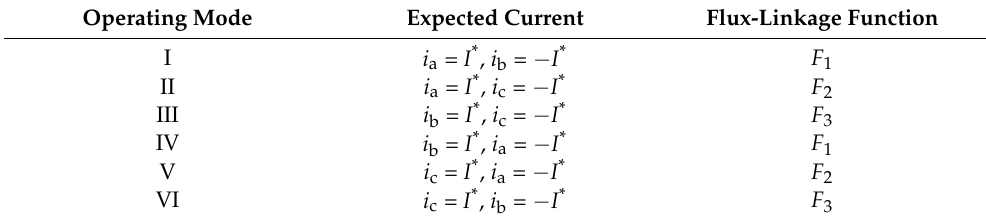
Table 2. Relationship between each operating mode and flux-linkage function.